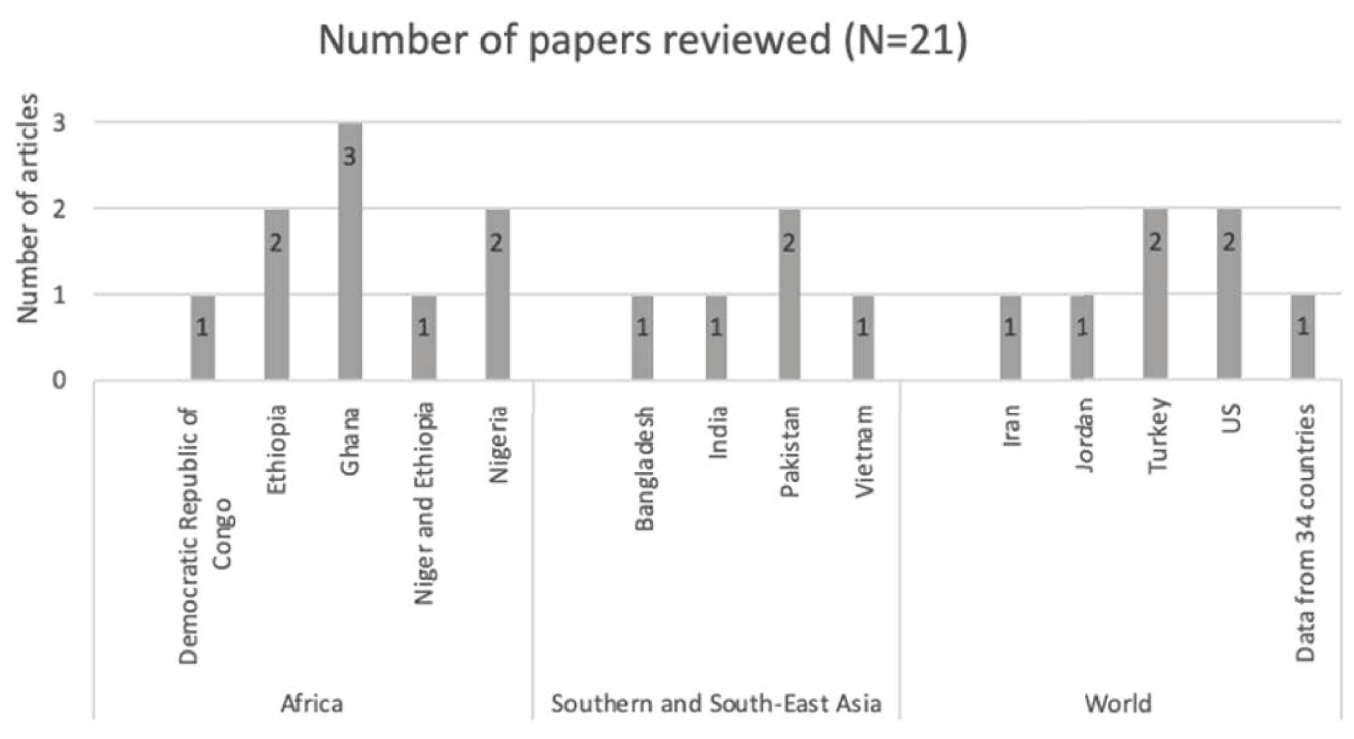
Fig 2. Countries examined in the articles included in our review.